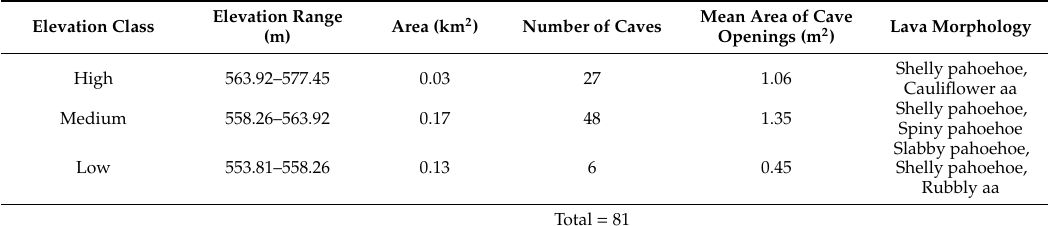
Table 3. Cave openings in various elevation classes and lava